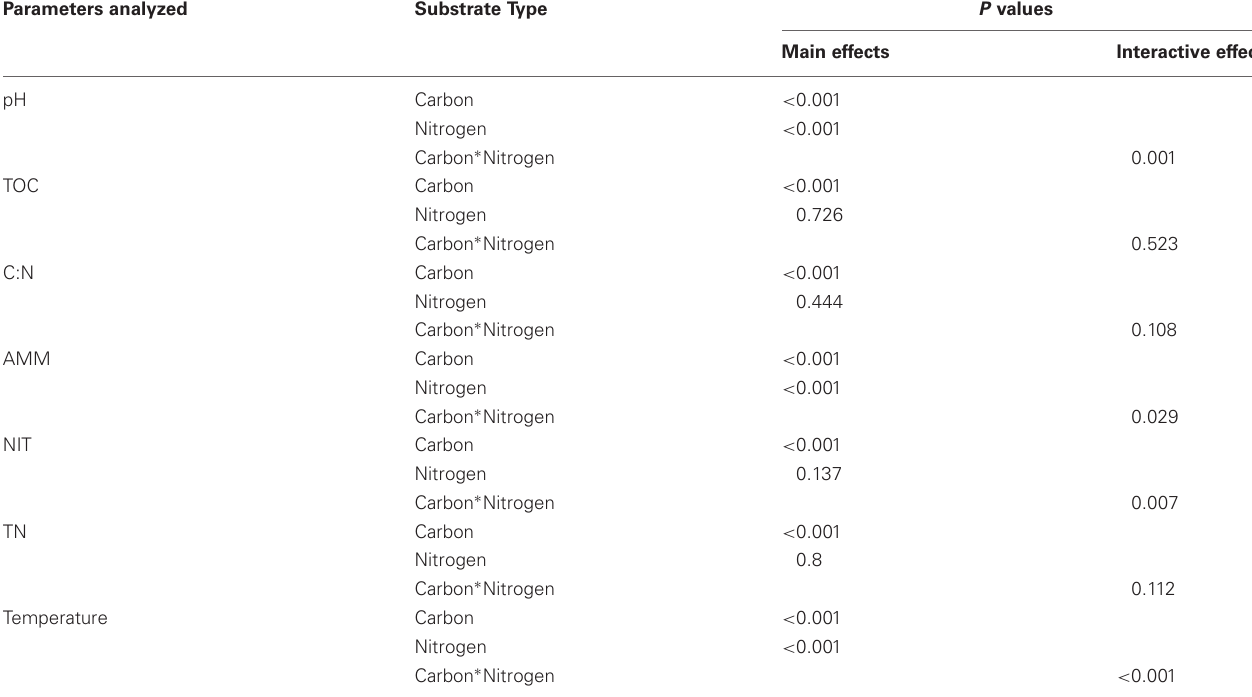
Table A1 | Statistical analyses for carbon and nitrogen substrates and interactive effects of bothsubstrates on physico-chemical parameters throughout the composting